Question: What form of chart is displayed?
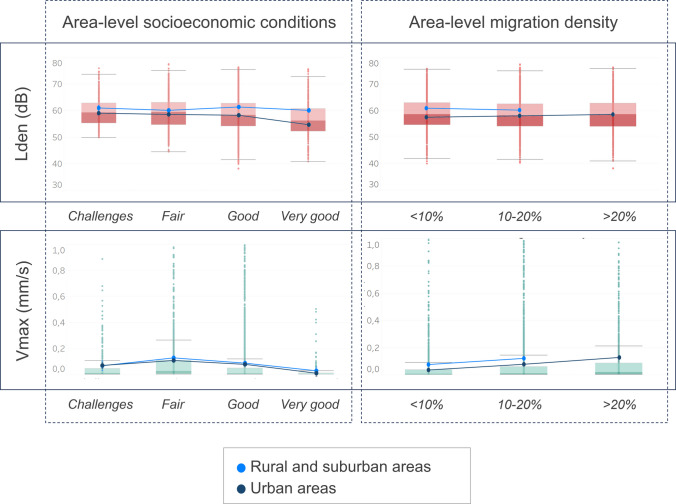
Answer: box